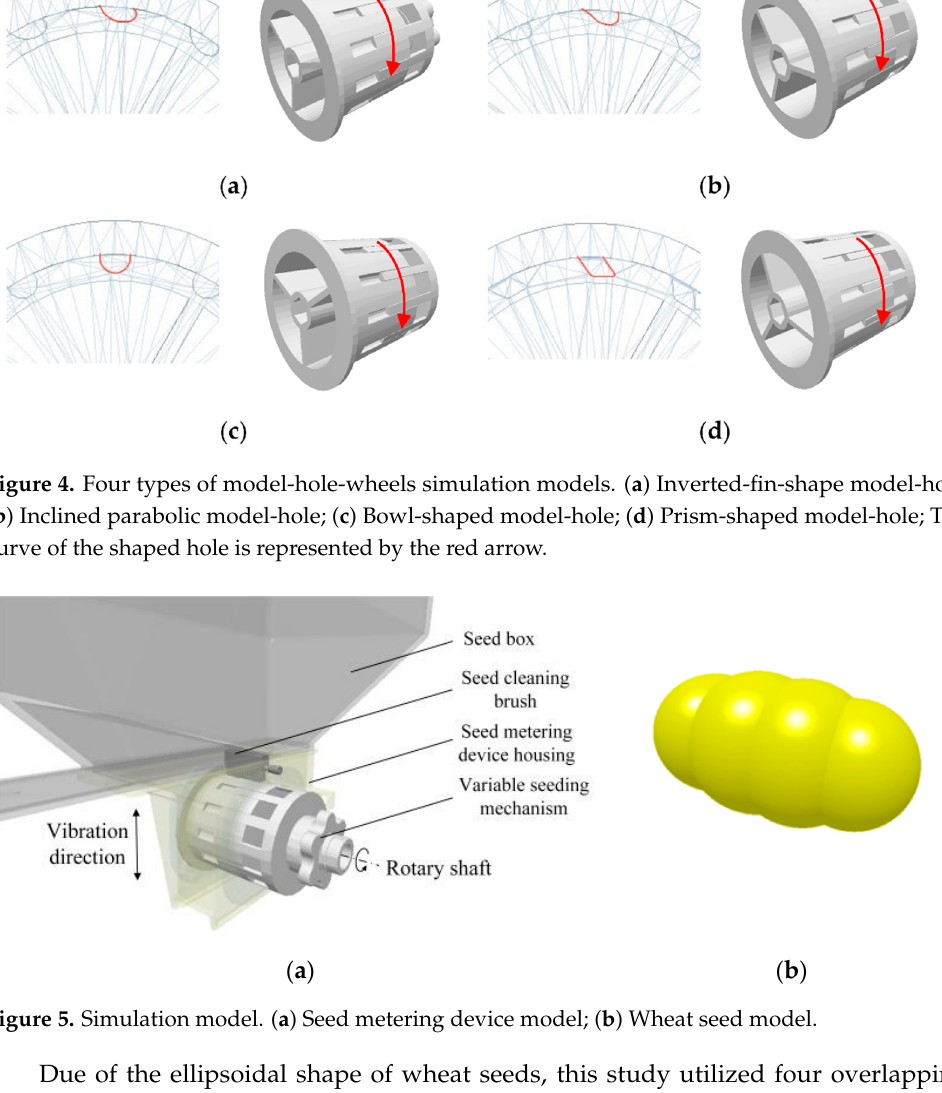
Figure 4. Four types of model-hole-wheels simulation models. ( a ) Inverted-fin-shape model-hole; ( b ) Inclined parabolic model-hole; ( c ) Bowl-shaped model-hole; ( d ) Prism-shaped model-hole; The curve of the shaped hole is represented by the red arrow.